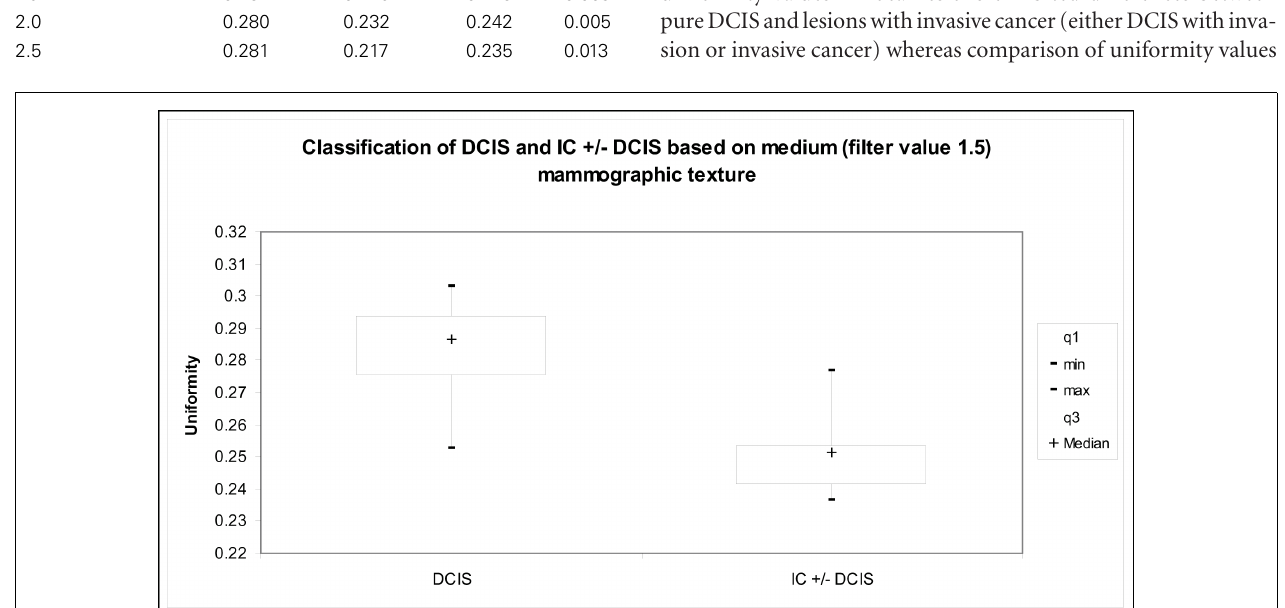
FIGURE 3 | Graph indicates the relationship between medium texture (uniformity) and presence of invasive tumor for the mammographic focal region of interest.